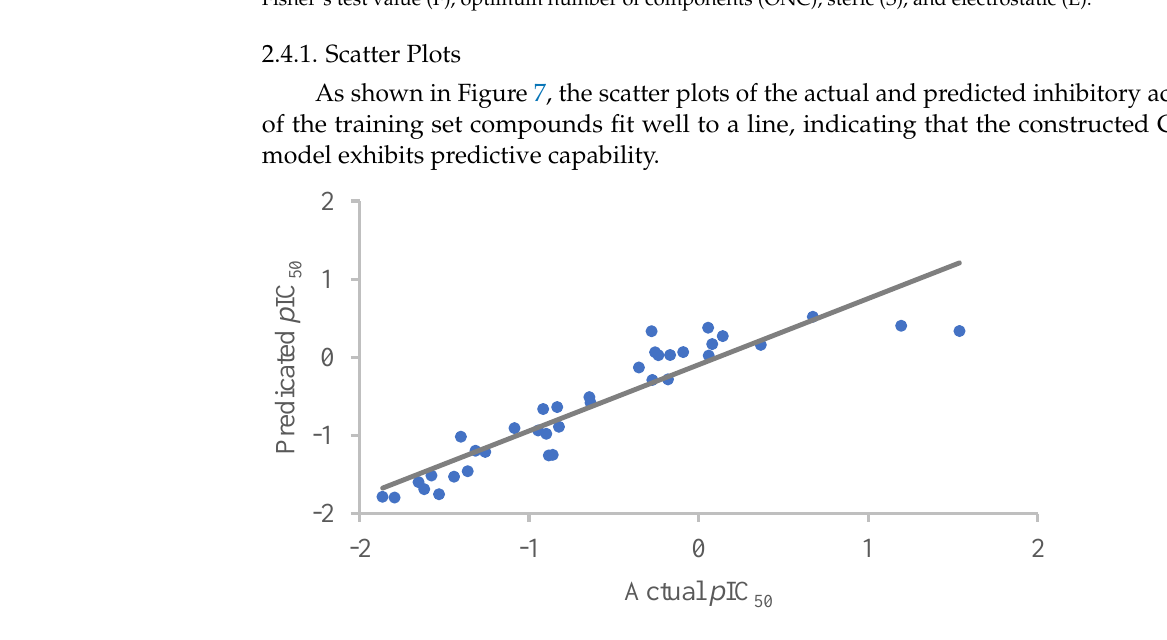
Figure 7. Scatter plots of the actual versus predicted p IC 50 for the CoMFA model.